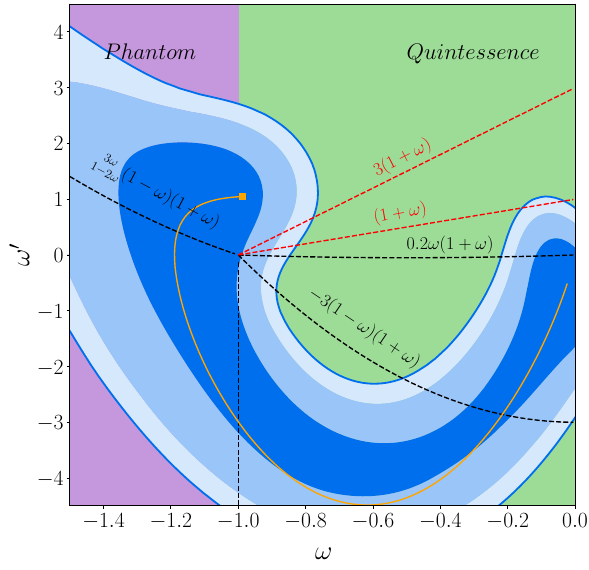
Fig. 7 Discrimination regions for quintessence (thawing and freezing behavior) and phantom models in the ω (cid:2) – ω plane. The red dashed lines represent the bounds for the thawing discrimination region, where ω (cid:2) = 3 ( 1 + ω) is the upper bound and ω (cid:2) = ( 1 + ω) is the lower bound [70]. The black dashed lines in the quintessence region ( ω > − 1) are the bounds for freezing models, where ω (cid:2) = 0 . 2 ω( 1 + ω) is the upper bound, and ω (cid:2) = − 3 ( 1 − ω)( 1 + ω) is the lower bound, see [72]. In the phantom region ( ω < − 1), ω (cid:2) = 3 ω( 1 − ω)( 1 + ω)/( 1 − 2 ω) is the upper bound, and ω = − 1 is the lower bound, see [71]. In shades of blue are the 68%, 95%, 99 . 7% confidence levels for the reconstruction of ω and ω (cid:2) using the joint constraints (CC++Pantheon), and the orange line is the mean value of these reconstructions. The orange square is the value at redshift z = 0